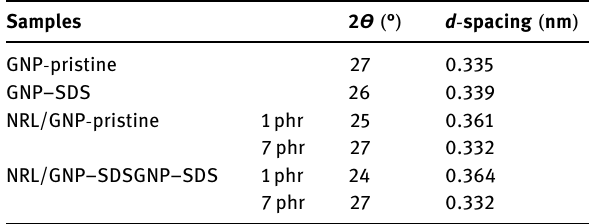
Table 2: The 2 Ɵ and d - spacing of un fi lled NRL and selected